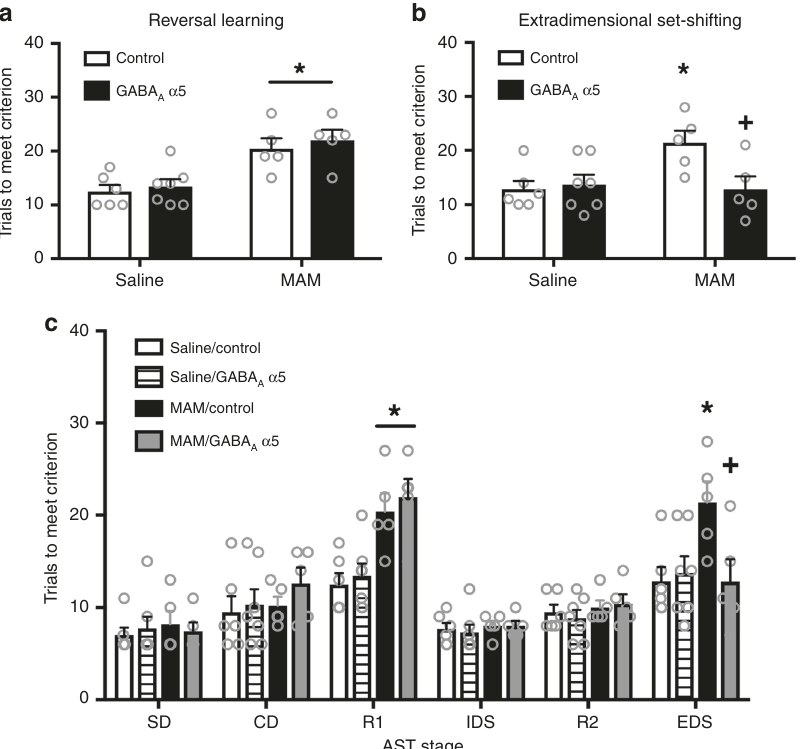
Fig. 3 α 5 overexpression improves some forms of cognitive fl exibility in the MAM model. The attentional set-shifting test (AST) was used to measure reversal learning and extradimensional set-shifting (ED), two forms of cognitive fl exibility. The MAM-induced de fi cit in reversal learning was not affected by over-expressing the α 5 subunit in the vHipp ( a ). Asterisk is a signi fi cant main effect compared to saline. The de fi cit in extradimensional set-shifting caused by MAM treatment is completely abolished by gene therapy to over-express the α 5 subunit of the GABA A receptor ( b ). Asterisk is signi fi cantly different than saline/control; + plus is signi fi cantly different than MAM/control. All stages of the AST are shown in c . SD is simple discrimination. CD is compound discrimination. R1 is the fi rst reversal. IDS is intradimensional set-shift. R2 is the second reversal. EDS is the extradimensional set-shift. n = 5 – 7 rats per group. All data were analyzed using Two-Way ANOVA and Holm – Sidak tests. Data are shown as mean ±